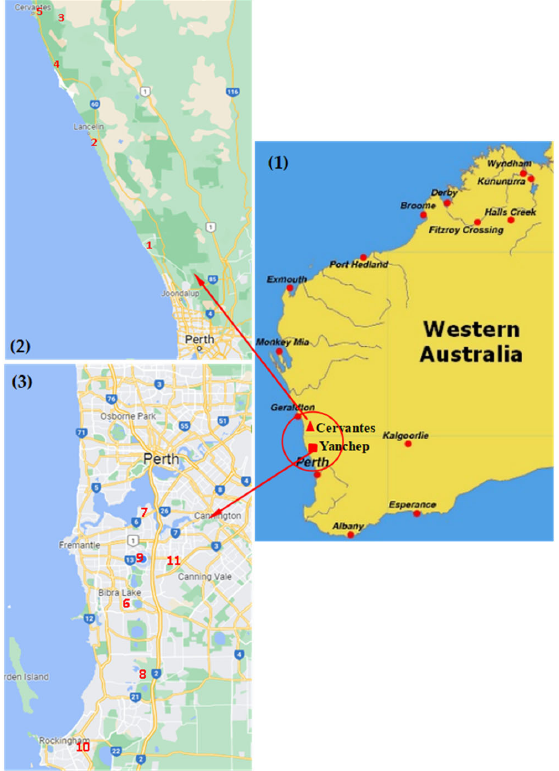
Figure 1. Locations of virus collection sites. ( 1 ) Western Australia showing the location of Perth, Yanchep, and Cervantes; ( 2 ) Sample collection sites to the north of the Perth metropolitan region: 1: Yanchep; 2, Ledge Point; 3, Lake Thetis; 4, dirt track in Cervantes region; 5, Cervantes